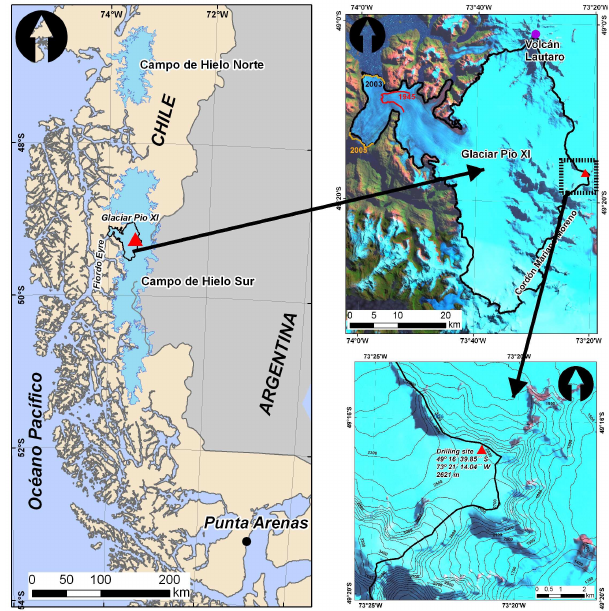
Fig. 1. Left: Map of Southern South America with Northern Patagonia Ice Field (NPI, Campo de Hielo Norte) and location of Pío XI glacier at the Southern Patagonia Ice Field (SPI, Campo de Hielo Sur). The red triangle marks the drilling site. Upper right: Landsat ETM, acquired on April 2, 2003, showing the area of Pío XI glacier with ice front position in 1945 (red line), 2003 (black), and 2005 (orange). Lower right: The northern plateau of Cordón Mariano Moreno including topographic information (contour lines) extracted from SRTM.